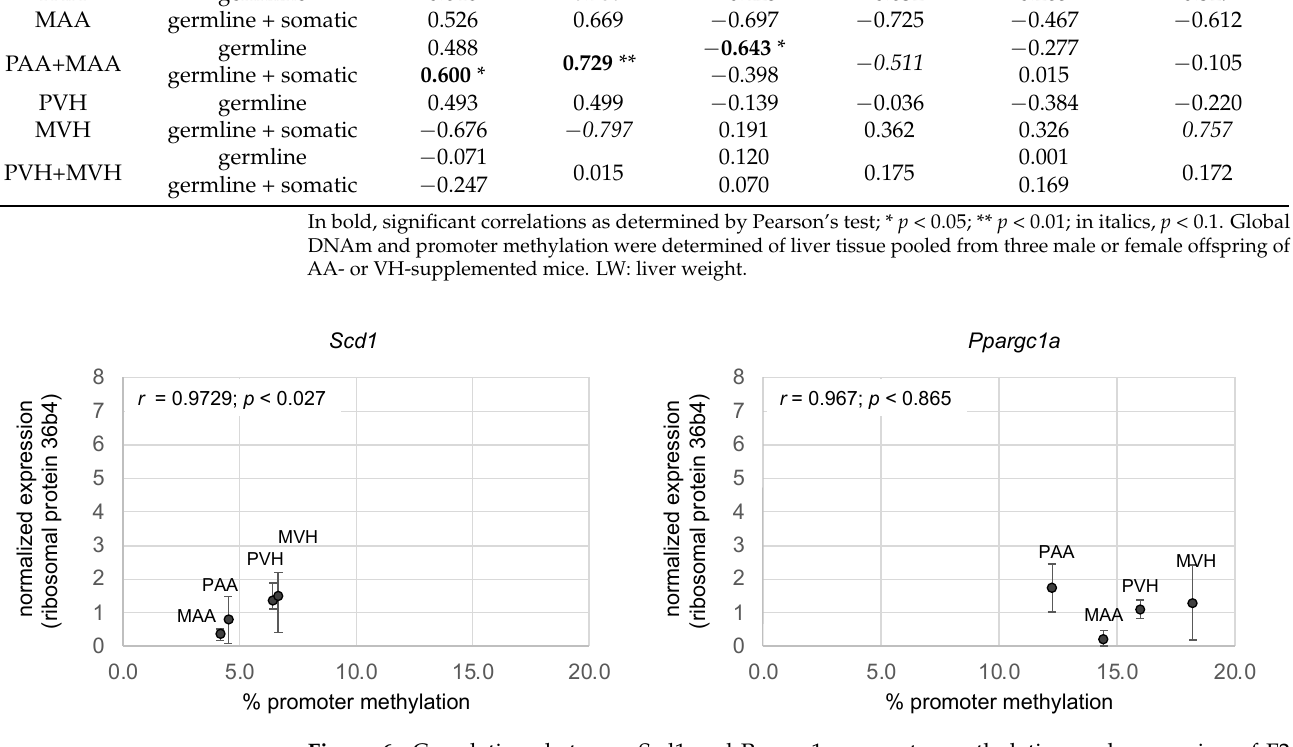
Figure 6. Correlations between Scd1 and Ppargc1a promoter methylation and expression of F2 offspring of AA- and VH-exposed mice. Each data point represents average normalized expression values of n = 6 mice (3 male and 3 females); Pearson’s r values are indicated in the upper left corner of each graph. Other abbreviations are as in Figure 3.